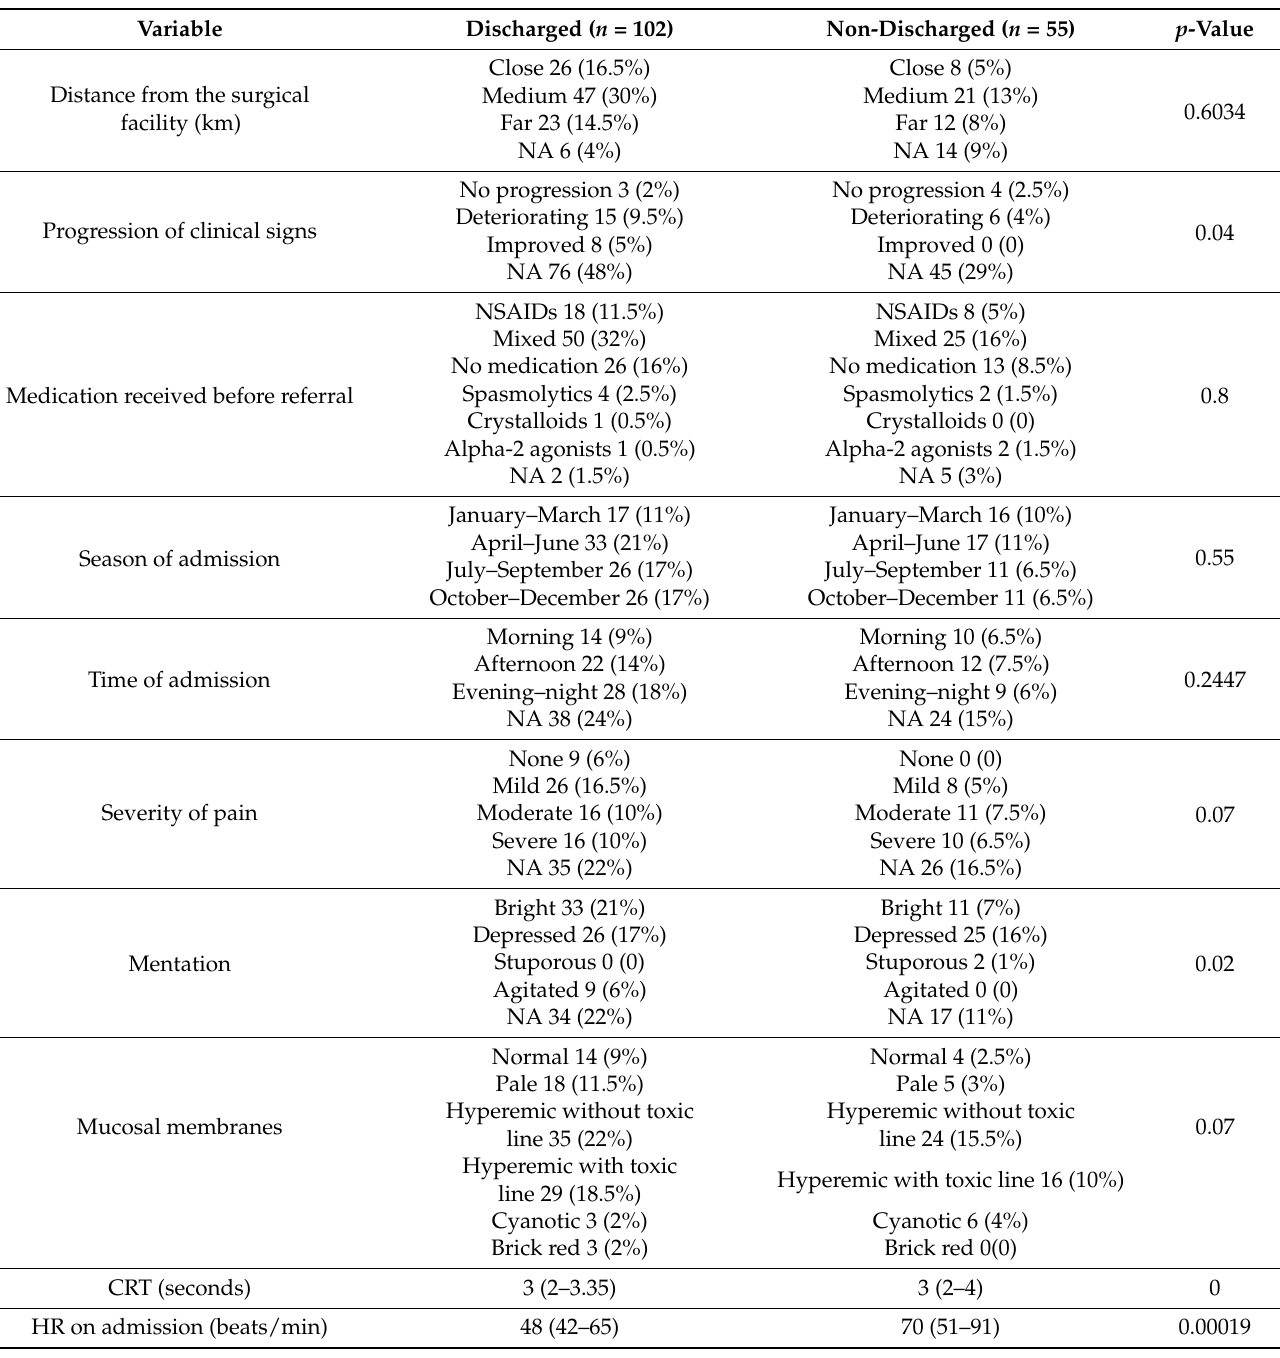
Table 3. Comparison of history data and clinical signs on admission between discharged and non-discharged horses (Distance from the surgical facility, Progression of clinical signs, Medication received before referral, Season of admission, Time of admission, Severity of pain, Mentation, Mucosal Membranes, Gastric Reflux, and Abdominal Distension, are expressed as frequency distribution (%); PCV, TP and rectal temperature are expressed as mean ± standard deviation; HR on admission, CRT, and HR at 3–6 h after admission/surgery are expressed as median and range) (NA: not available; CRT: capillary refill time; HR: heart rate; PCV: packed cell volume; and TP: total